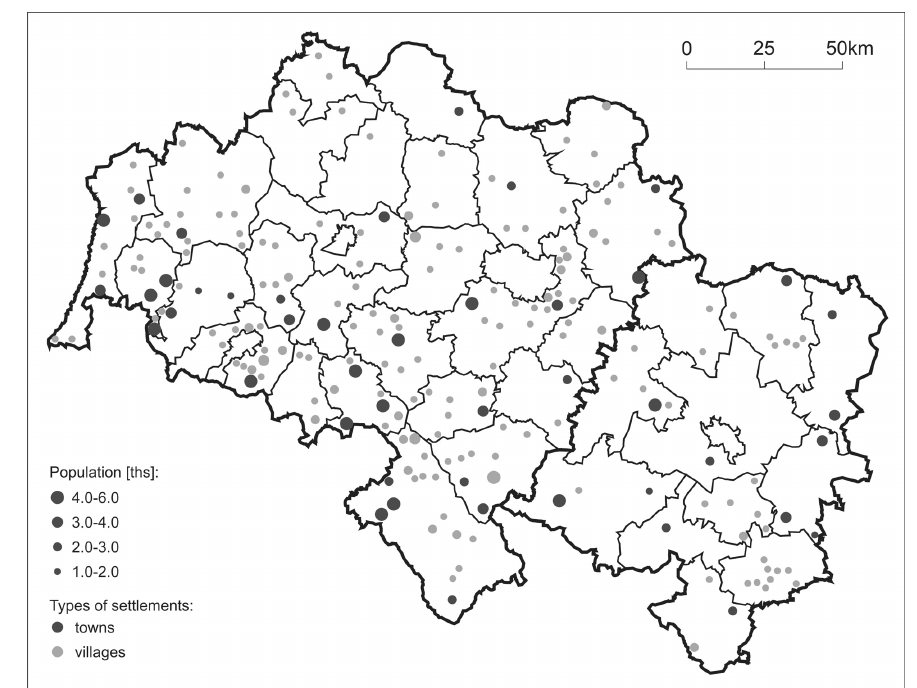
Fig. 5. Distribution and population (2002) of small towns and big villages in the south-west region of Poland. Source: own